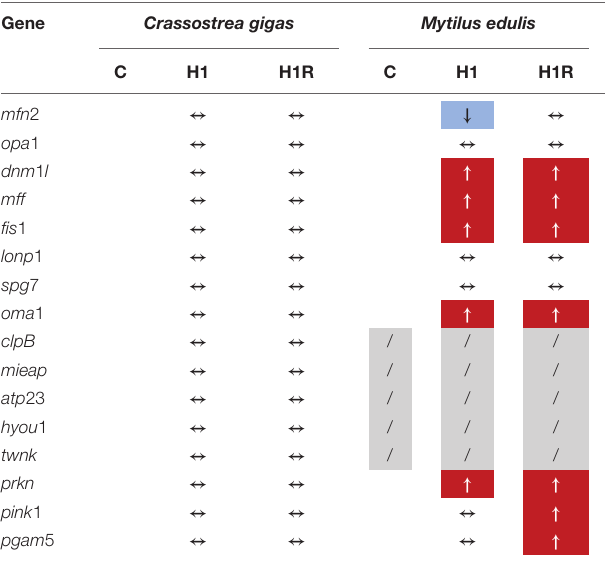
TABLE 2 | Summary of the observed changes in mRNA expression patterns of the mitochondrial quality control genes in Crassostrea gigas and Mytilus edulis . Gene Crassostrea gigas Mytilus edulis